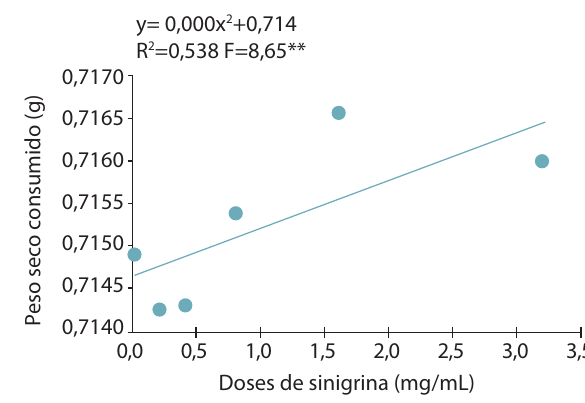
Figura 6. Curva ajustada para regressão polinomial entre o peso fresco consumido de folhas de brócolis por lagartas de Plutella xylostella e doses de sinigrina .